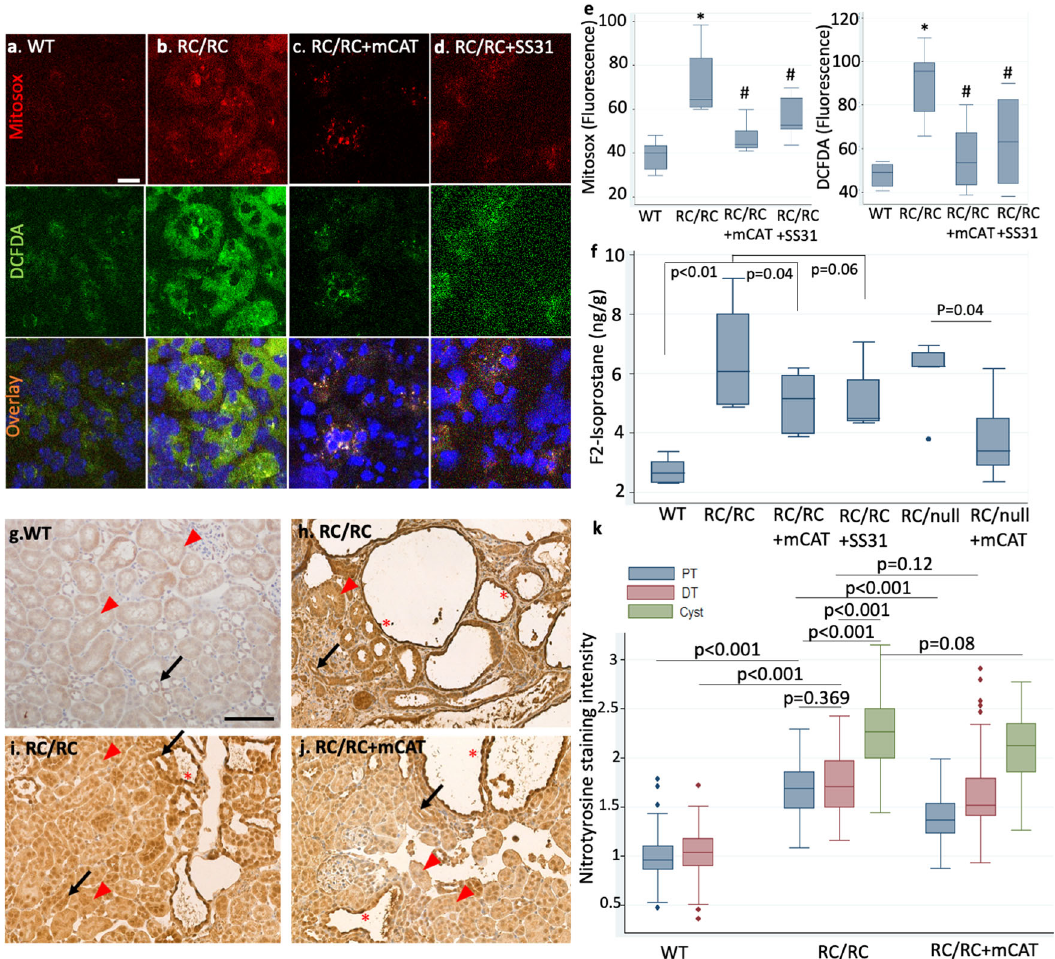
Fig. 8 ROS and oxidative damage in RC/RC kidneys. Representative images of ex vivo live staining of kidney slices with MitoSOX (top row), an indicator of mitochondrial superoxide and DCFDA (middle row), an indicator of total cellular ROS, overlaid with Hoechst 33342 (bottom row) in kidneys from a WT and b RC/RC mice or RC/RC mice treated with c low dose AAV9-mCAT (RC/RC + mCAT) or d the mitochondrial protective peptide SS31; n = 3 − 4 per group (scale bar: 25 µ m). e Quanti fi cation of ROS from cells treated as in ( a – d ). f Concentration of F2-isoprostane, a marker of lipid peroxidation in kidney tissue of WT, RC/RC, RC/RC treated with mCAT or SS31, RC/null and RC/null treated with mCAT, measured by high-performance liquid chromatography; n = 4 − 6. * p < 0.01 vs. WT; # p < 0.05 vs. RC/RC. IHC staining for nitrotyrosine in g WT, h , i RC/RC, and j RC/RC treated with AAV9-mCAT and k quanti fi cation of nitrotyrosine staining intensity as in ( g – j ). (Scale bar: 100 µ m); PT: red arrowhead, DT: black arrow, *: cysts; n = 3 per group; PT: proximal tubule, DT: distal